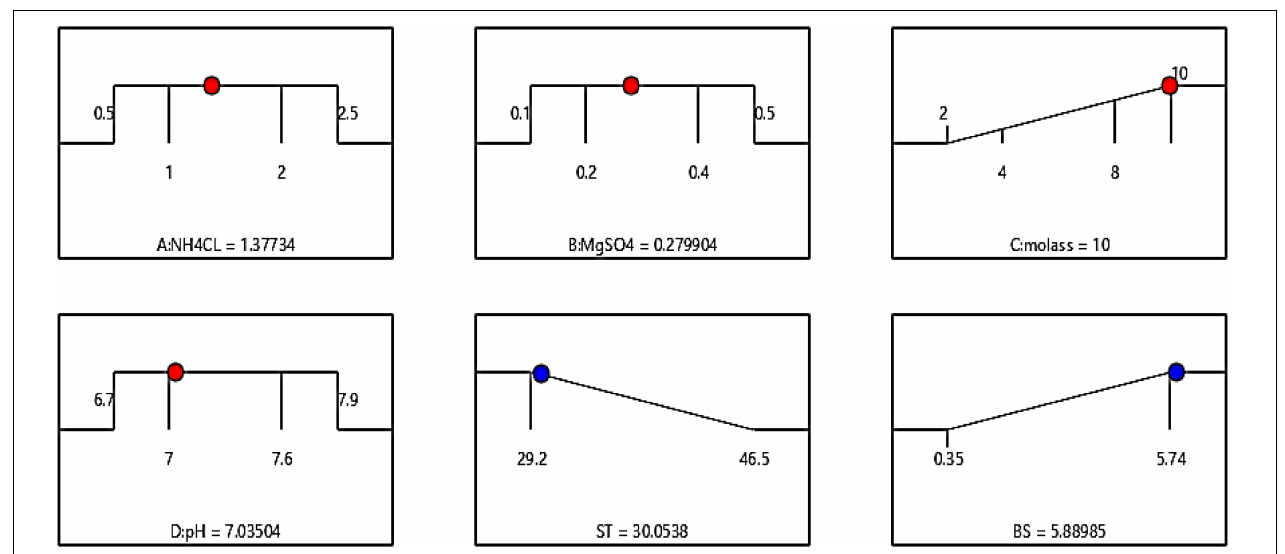
FIGURE 6 | Optimal conditions predicted by the software, by adjusting the molasses factor levels to the maximum value